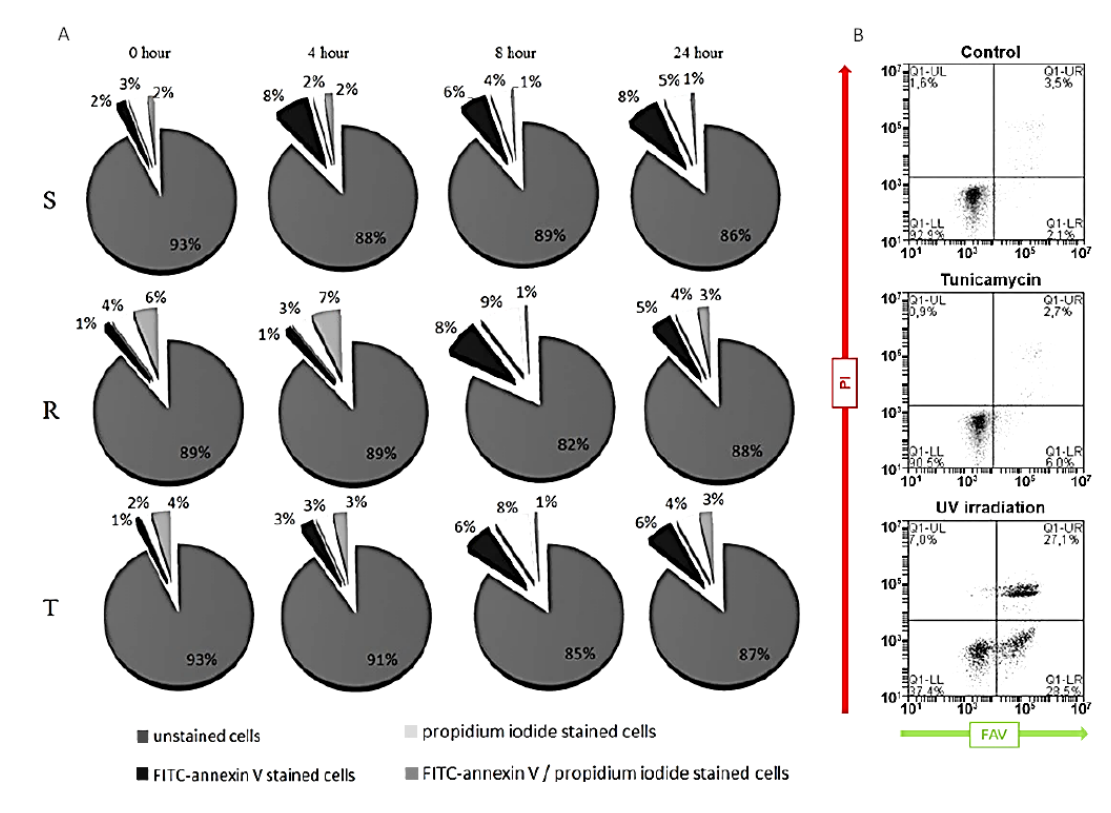
Figure 1. Determination of cell viability by fluorescein isothiocyanate -labeled annexin V (FAV) / propidium iodide (PI) assay: The cells were incubated for 24 h in the absence (control) or presence of 0.1 µ M tunicamycin prior to the measurements. ( A ) Proportion of S, R, and T cells that were unstained (viable cells), stained with FAV (apoptotic cells), stained with PI (necrotic cells), and stained with both FAV and PI (late apoptotic / necrotic cells): Data in the pie charts are representative of three independent measurements. ( B ) Control apoptosis / necrosis induction after 10 min of UV irradiation of R cells using a germicide lamp and subsequent 24-h cell culture is shown as dot blots. Lower left quadrant: unstained cells; lower right quadrant: cells stained by FAV; upper left quadrant: cells stained by PI; and upper right quadrant: cells stained by both FAV and PI. Data are representative of three independent measurements, and similar data were also observed for S and T cells (not shown).